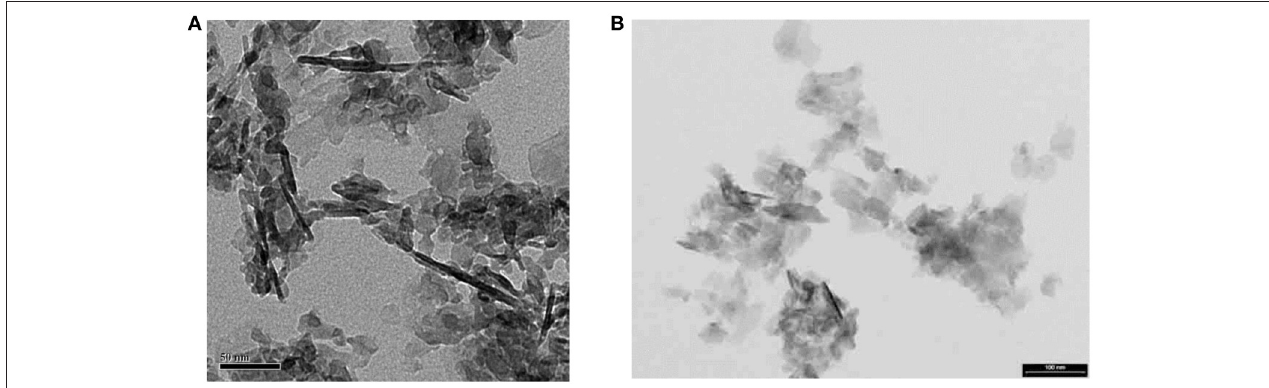
FIGURE 4 | Isolated crystals extracted from bone using NaClO (bleach): (A) from experiments with E. McNally (unpublished); note that dark linear objects ∼ 100 nm long are edge-wise views of fragments of mineral lamellae; most of the light-gray objects in the image are also ML fragments lying flat on the carbon grid. Scale = 50nm; (B) from Trueman et al. [50]. Some ML fragments are also present in this image. Smallest objects are single apatite crystals. Scale = 100 nm.